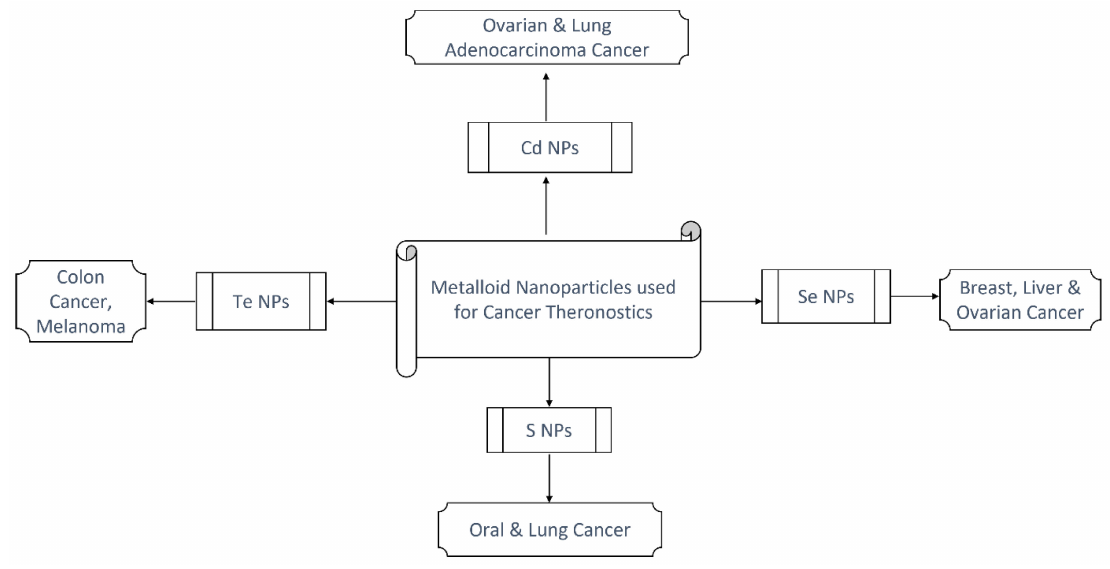
Figure 5. Summary of chalcogen nanoparticles with their therapeutic